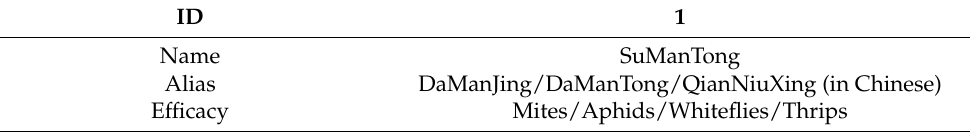
Table 4. Pyridaben (“SuManTong” in Chinese)-related attribute recognition.